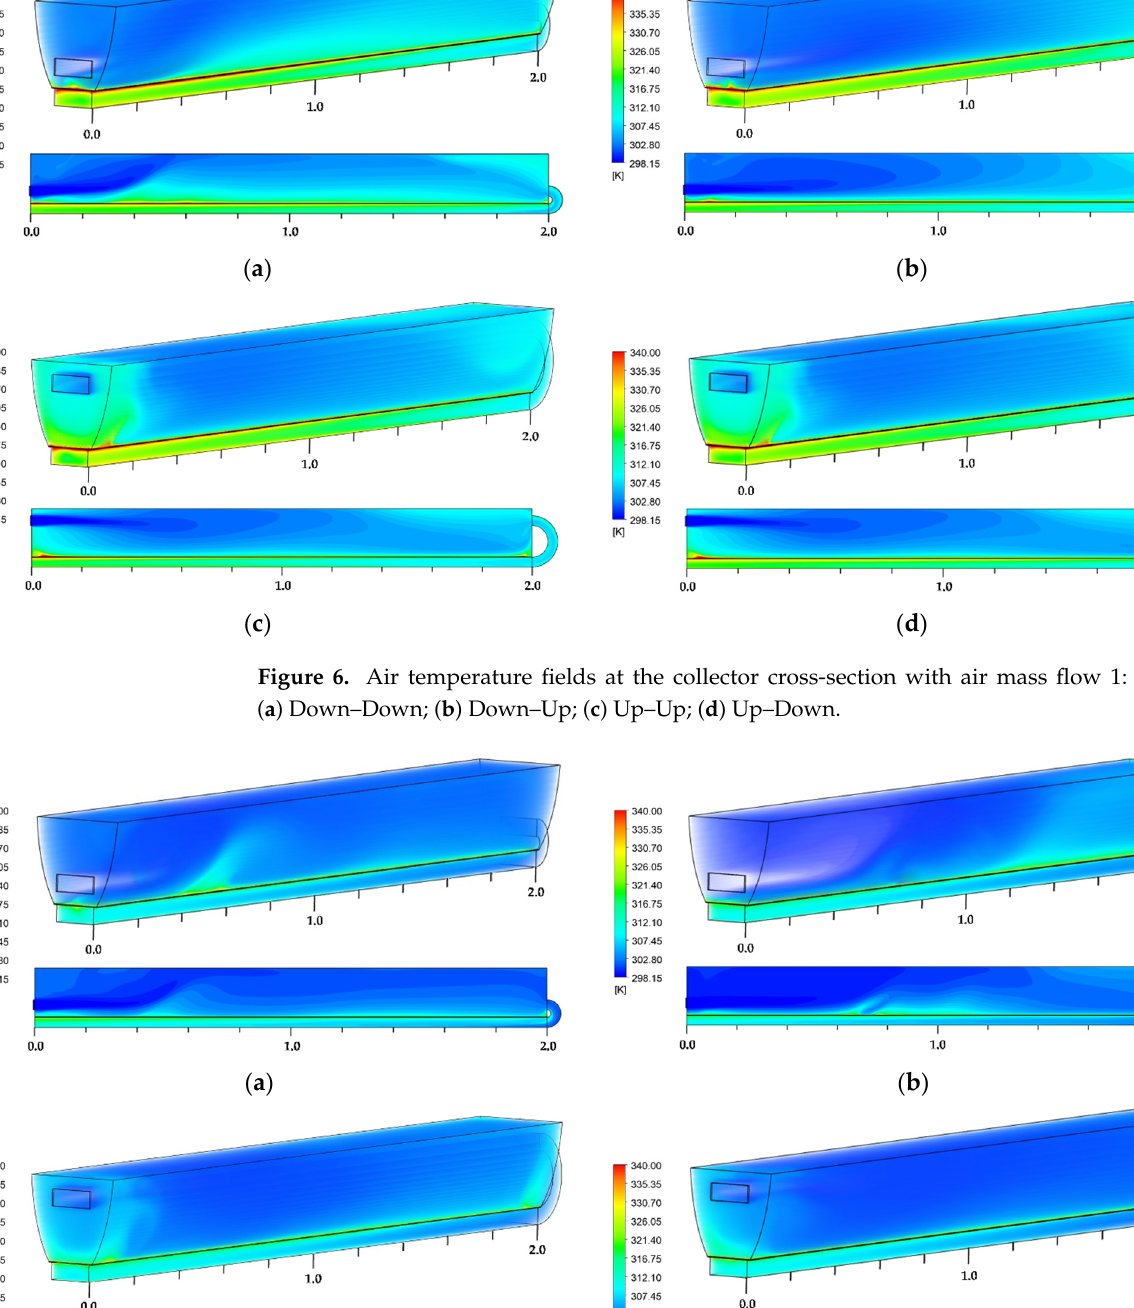
Figure 7. Air temperature fields at the collector cross-section with air mass flow 2: 0.02 kg/s. ( a ) Down–Down; ( b ) Down–Up; ( c ) Up–Up; ( d ) Up–Down.